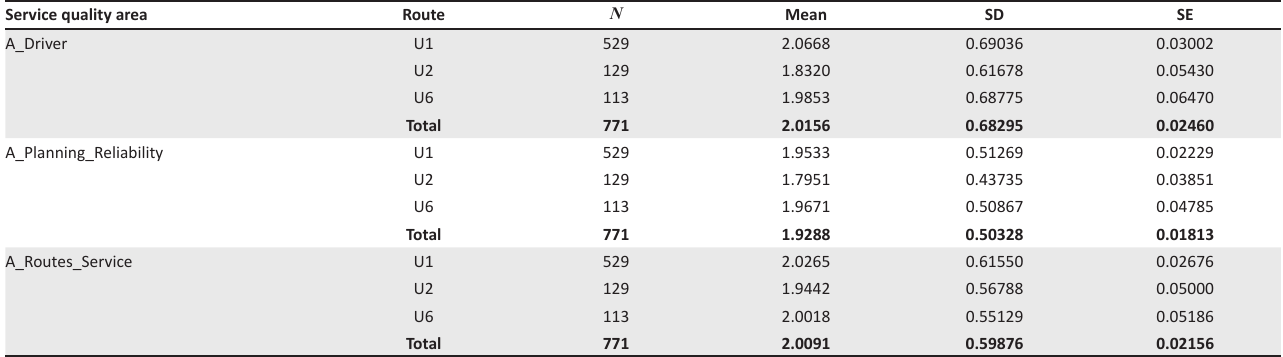
TABLE 15: Routes and service quality areas. Service quality area